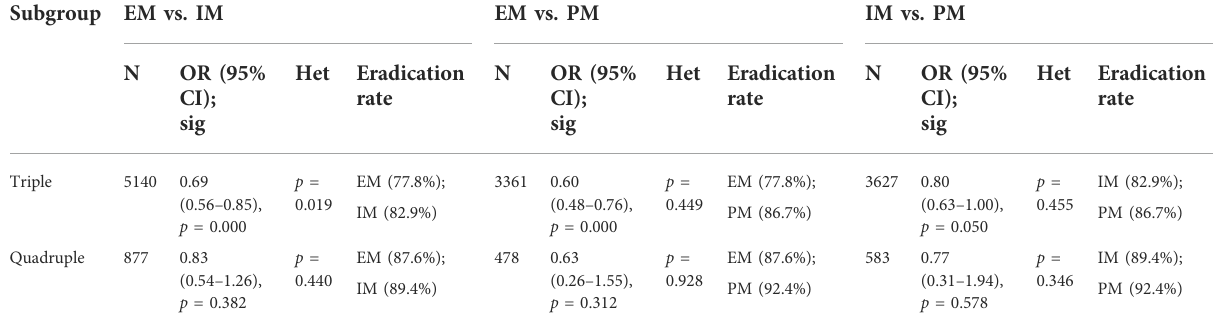
TABLE 7 Ef fi cacy of CYP2C19 polymorphism on the cure rates of H. pylori in triple therapy and quadruple therapy. Subgroup EM vs. IM EM vs. PM IM vs.